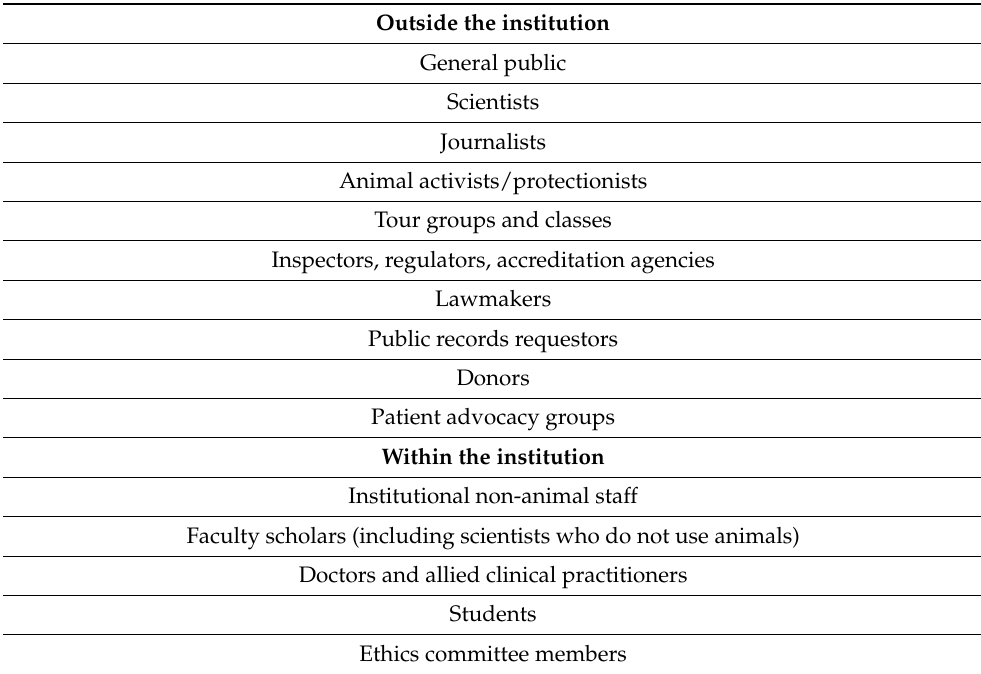
Table 2. Some potential recipients of animal research